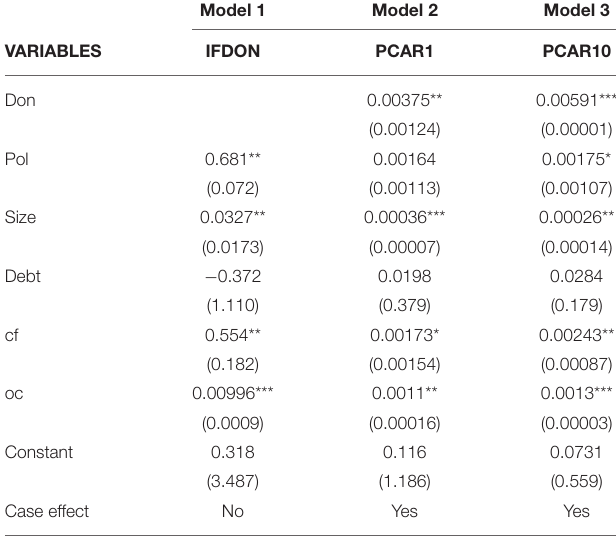
TABLE 7 | Summary of the regression results of Heckman two-stage